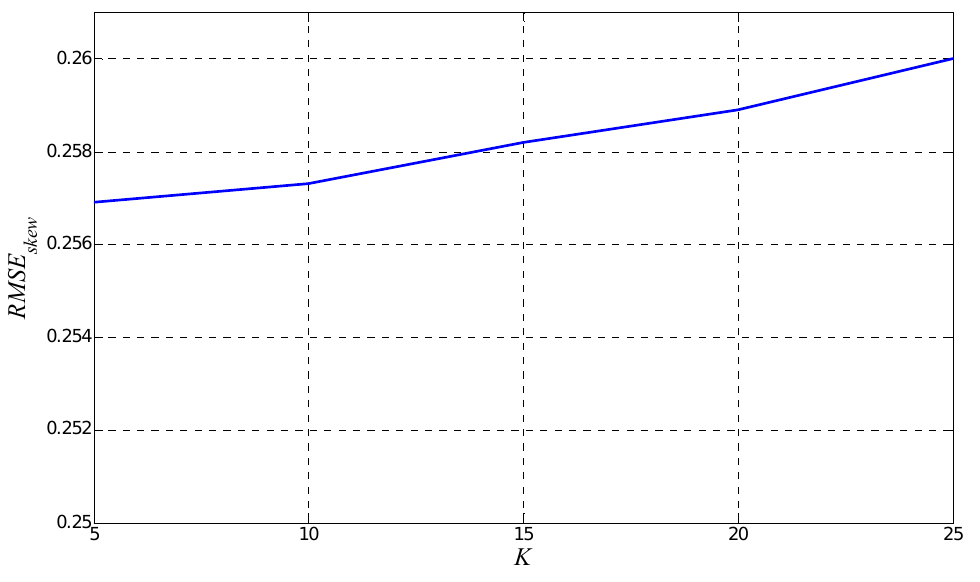
from the single line skew test. skew